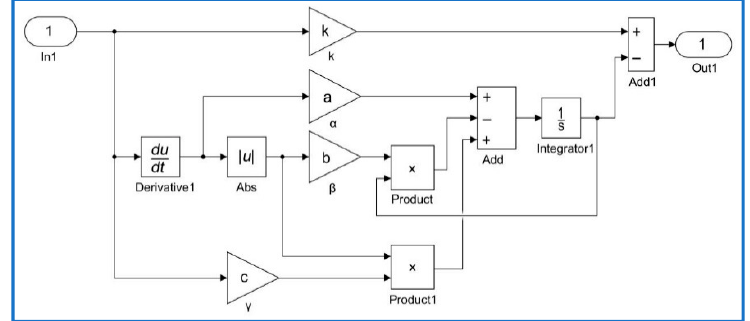
Figure 3. Classical Duhem model implemented with Matlab/Simulink.